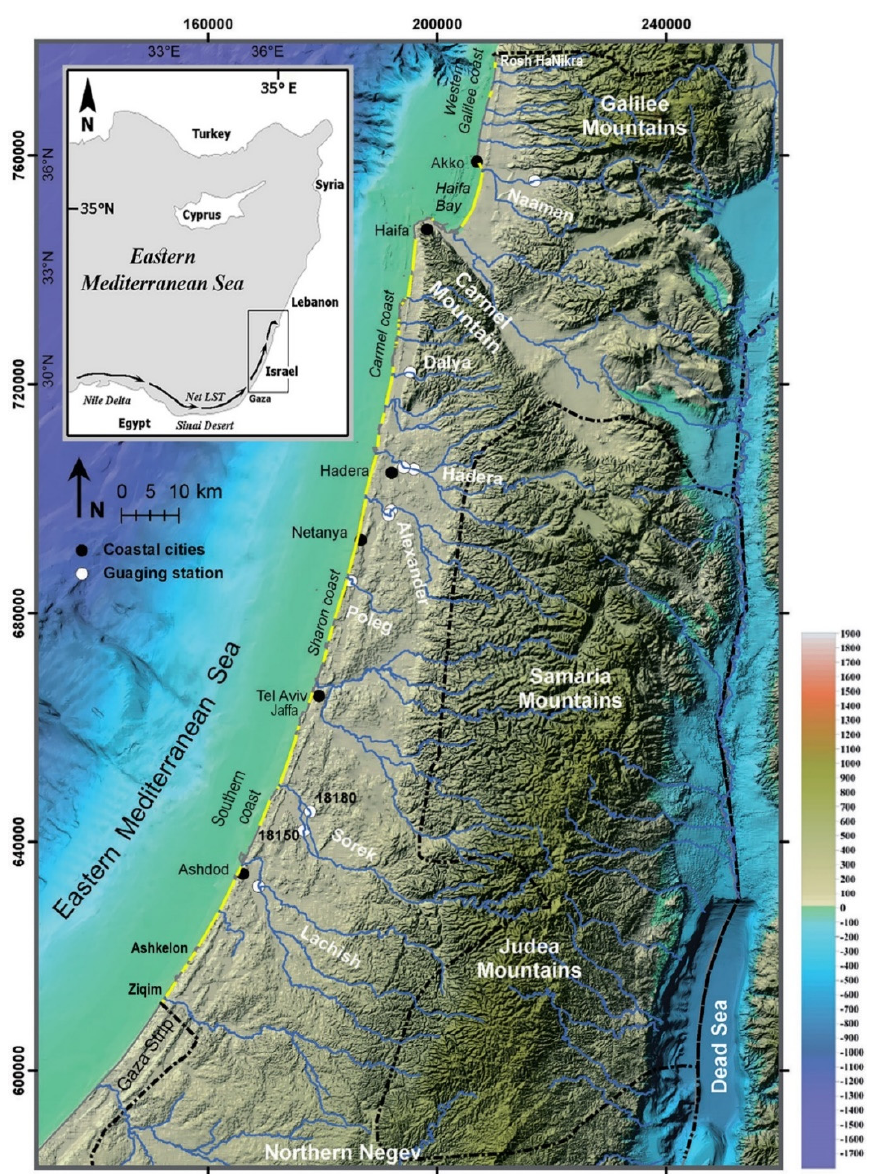
Figure 2. Locations of Israel’s main coastal cities, sandy beaches (marked yellow), main rivers, and seasonal streams (modified after Lichter et al. 2011 [15]). Background: Shaded relief modified after Hall and Calvo [16]. Inset: The Nile littoral cell longshore sand transport (LST) long-term dominant